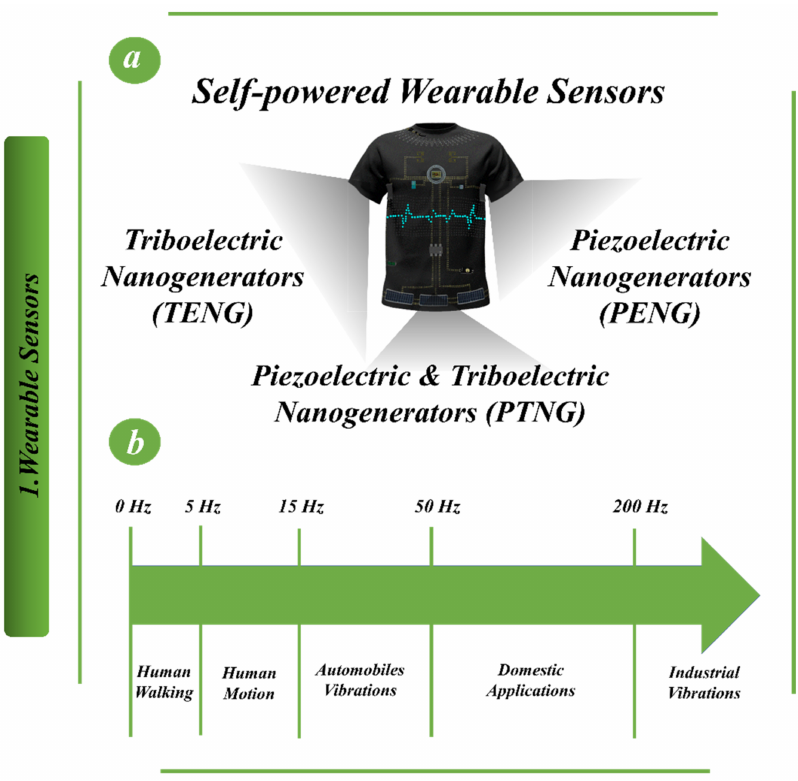
Figure 1. ( a ) Self-powered wearable sensors based on piezoelectric and triboelectric nanogenerators ( b ) Frequency levels of common mechanical energy